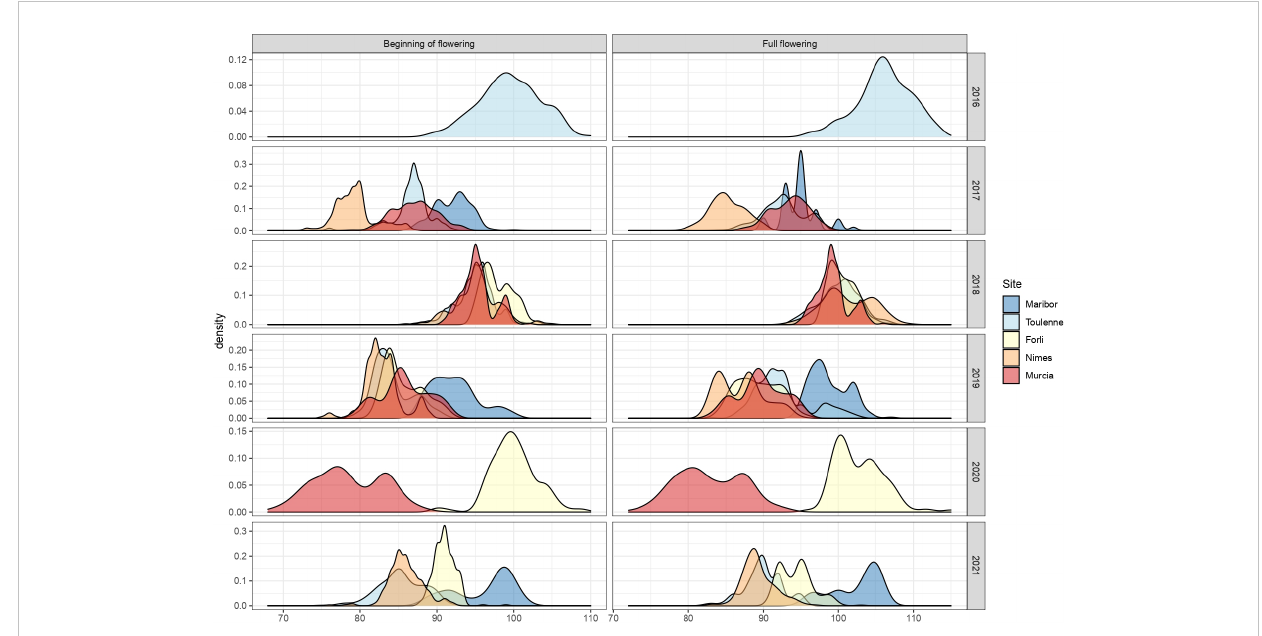
FIGURE 2 Distribution of beginning of fl owering and full fl owering (scored in JDs) across the different sites of the MET between 2016 and